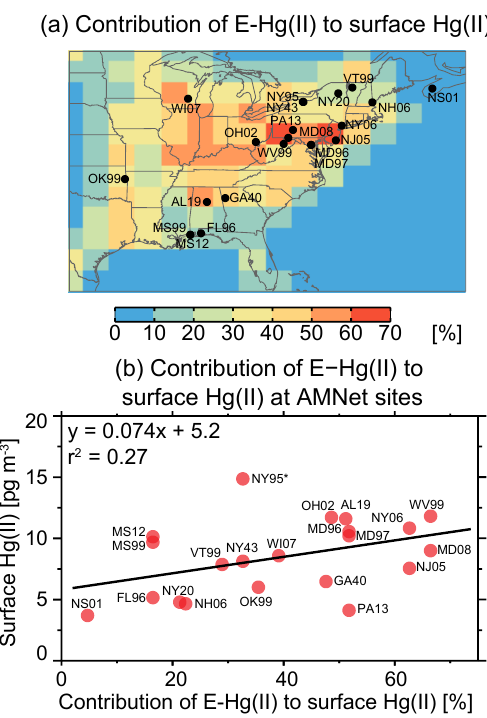
Figure 10. (a) Simulated surface concentration of Hg(II) for 2013– 2014. Also shown are the locations of the AMNet stations mapped to the model grid. (b) Relationship between the 2009–2012 median Hg(II) concentrations observed at the AMNet sites and the contribu- tion of E-Hg(II) tracer to surface Hg(II) concentrations. The black line is the best-fit line from ordinary least-squares regression. The text displays the regression equation and the square of the correla- tion coefficient ( r 2 ). The outlier NY95 is excluded from the regres- sion